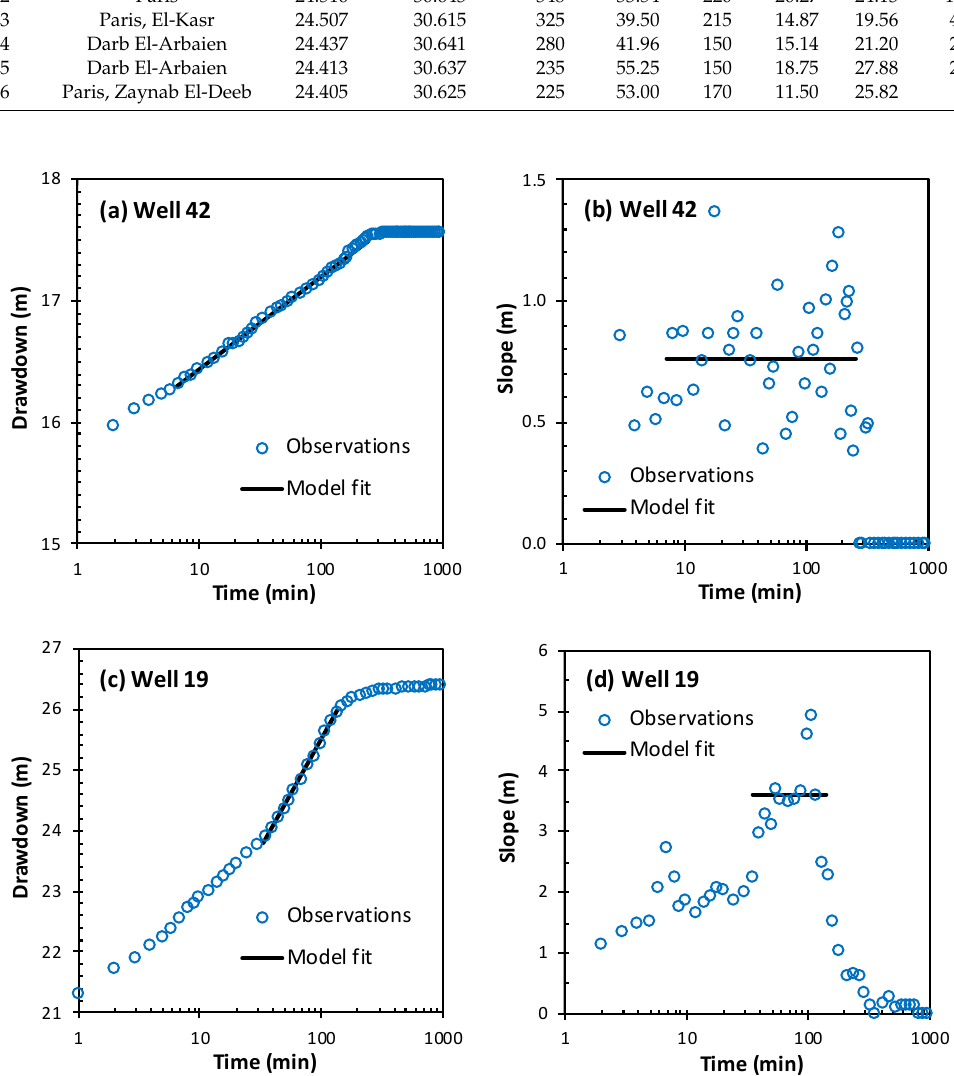
Figure 3. Plots showing drawdown against log-time for well 42 ( a ), slope of drawdown against log-time for well 42 ( b ), drawdown against log-time for well 19 ( c ) and slope of drawdown against log-time for well 19 ( d ); the solid line shows the straight-line fit to estimate the transmissivity.